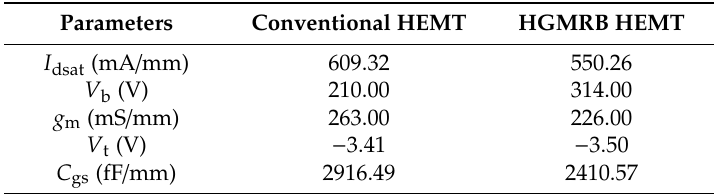
Table 2. Parameters of the conventional high-electron-mobility transistor (HEMT), and proposed HEMT with a high gate and a multi-recessed bu ff er